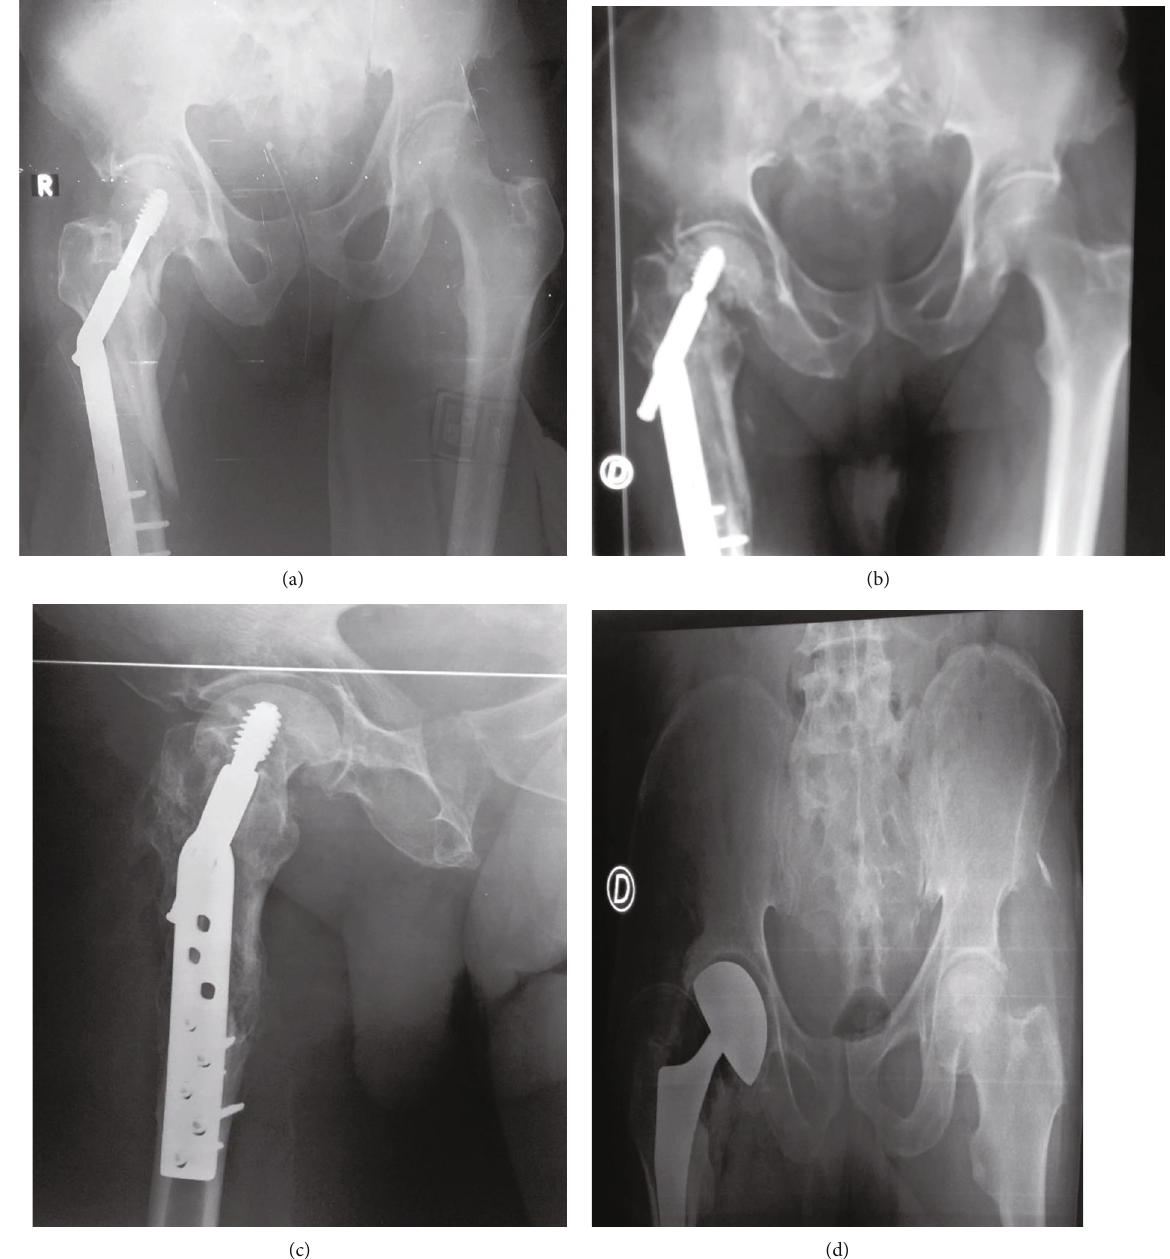
Figure 3: X-rays of patient 3. (a) Osteosynthesis y DHS. (b) Subtrochanteric malunion with pseudarthrosis of femur neck. (c) Cut out phenomenon. (d)